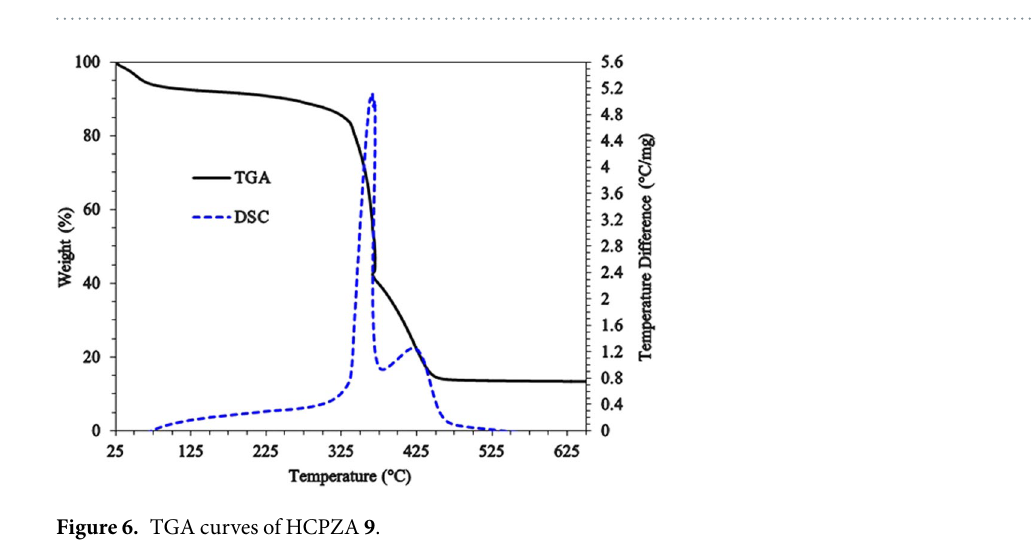
Figure 5. IR Spectra of the cross-linked resin ( a ) in acidic form 9 and ( b ) in basic form 10 . IR Spectra of ( c ) dye-loaded resin 9 , ( d ) Hg-loaded resin 9 and ( e ) Dye, Hg-loaded resin 9 .